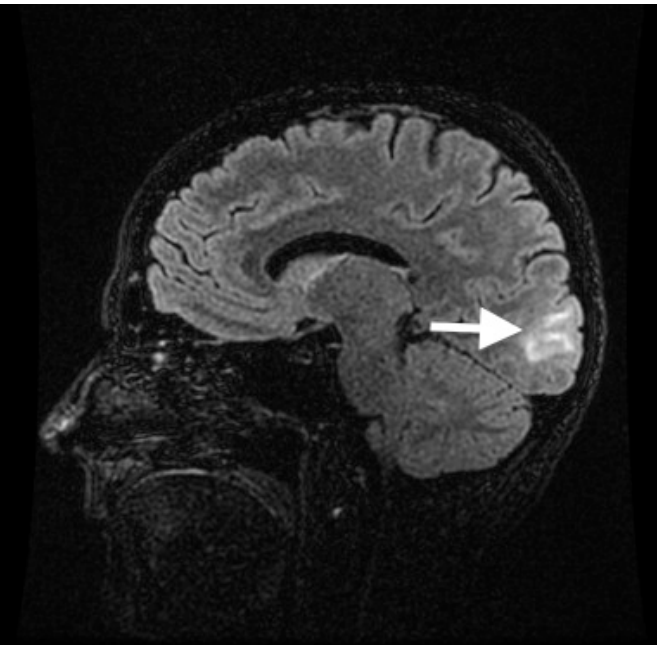
Figure 1. T2 weighted magnetic resonance imaging of Patient 1, showing hyperintensity within the occipital